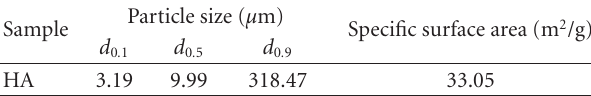
Table 2: Particle size of HA.